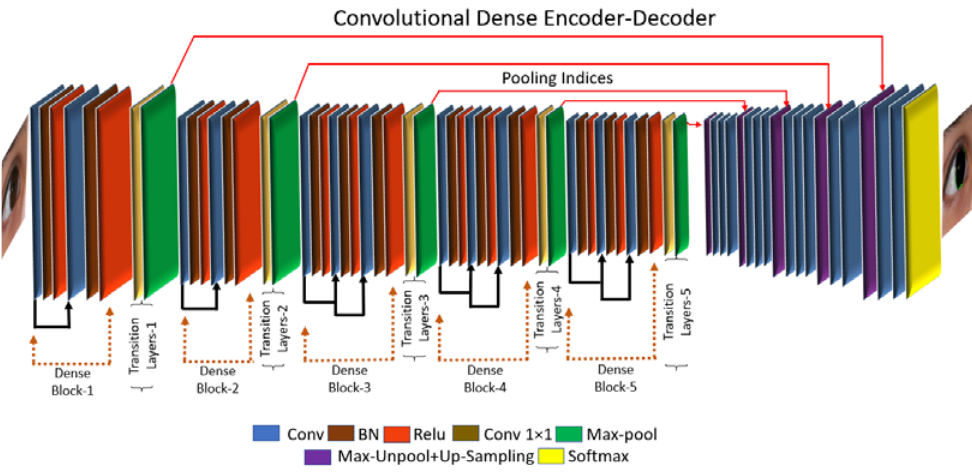
Figure 2. Overview of the proposed method.